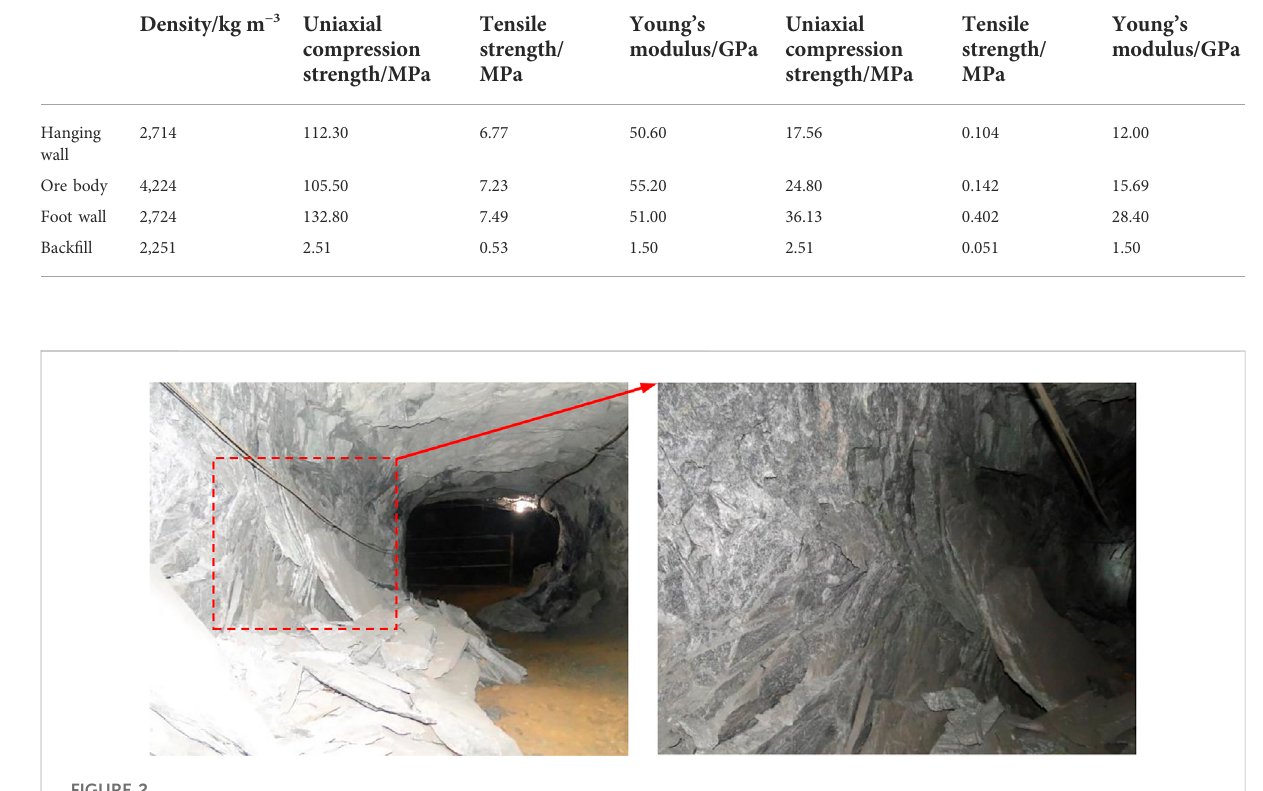
FIGURE 2 Spalling failure of the ramp surrounding rock in the 13#